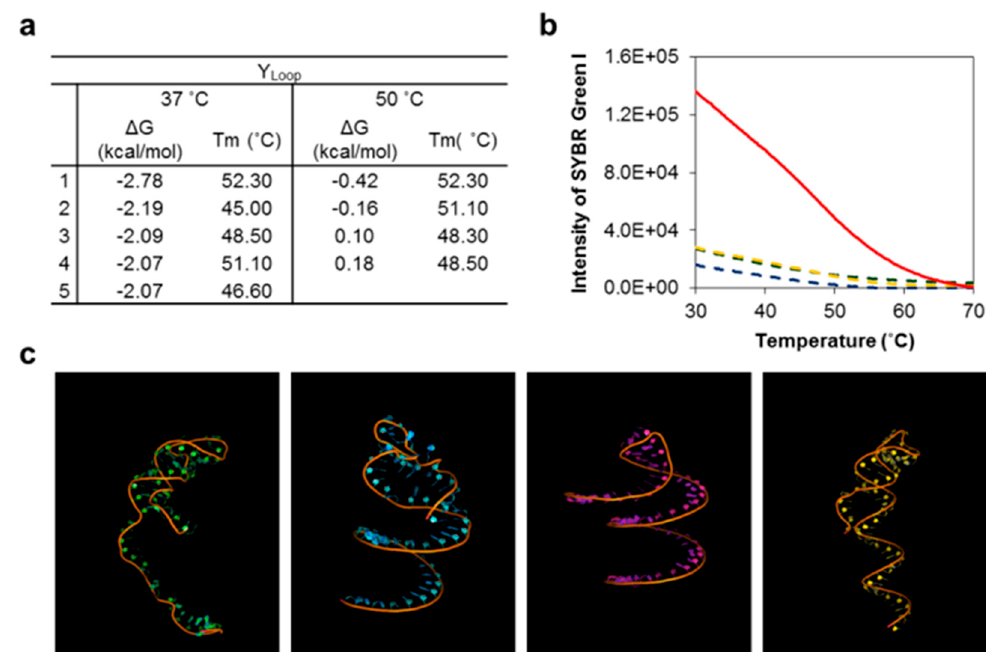
Figure 2. Empirical and theoretical analyses of possible secondary structures of L-DNA. ( a ) Theoretical analysis of the secondary structures of L-DNA via the Mfold program. Y L , which contains a loop–stem form, exhibited possible secondary structures with high thermodynamic stability at both 37 °C and 50 °C. Both Gibbs free energy and T m values of its secondary structures are described in the Table. ( b ) Melting curves of Y 1 (green), Y 2 (blue), Y 3 (orange), and Y L (red) as measured by RT-PCR. The graph indicates changes in fluorescence intensity of SYBR green I, which is specific to double-stranded DNAs. Data were obtained from triplicate experiments. ( c ) Three-dimensional topographic images of four different types of possible secondary structures of Y L at 50 °C.